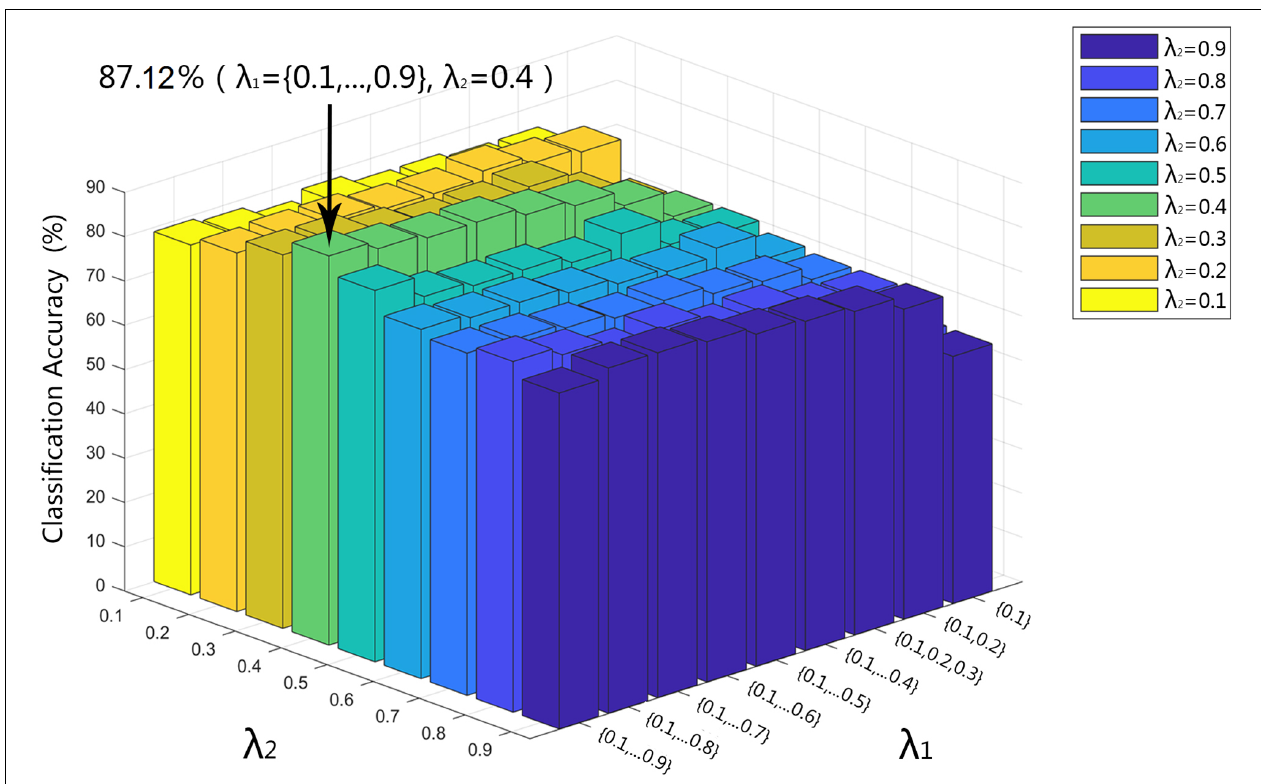
FIGURE 11 | Classification accuracy of different regulation parameters ( λ 1 , λ 2